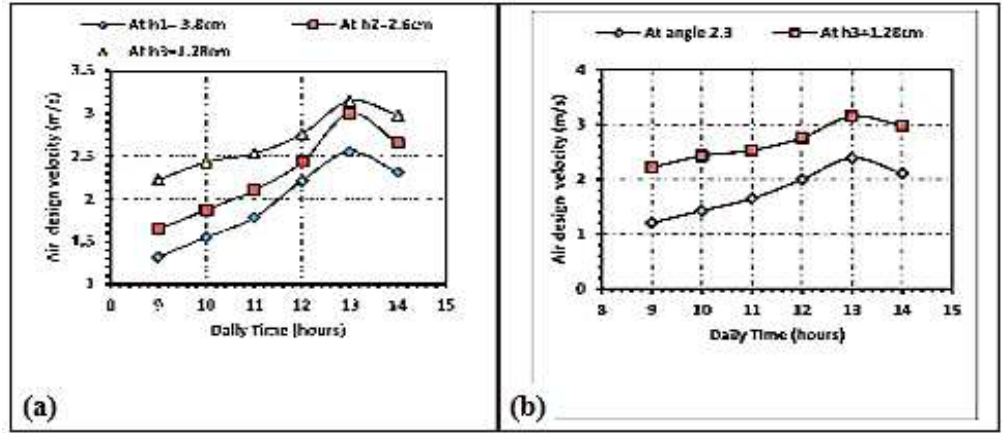
Fig. 10. Variation of air velocity versus time (a)with reduction area. (b) with and without reduction area.